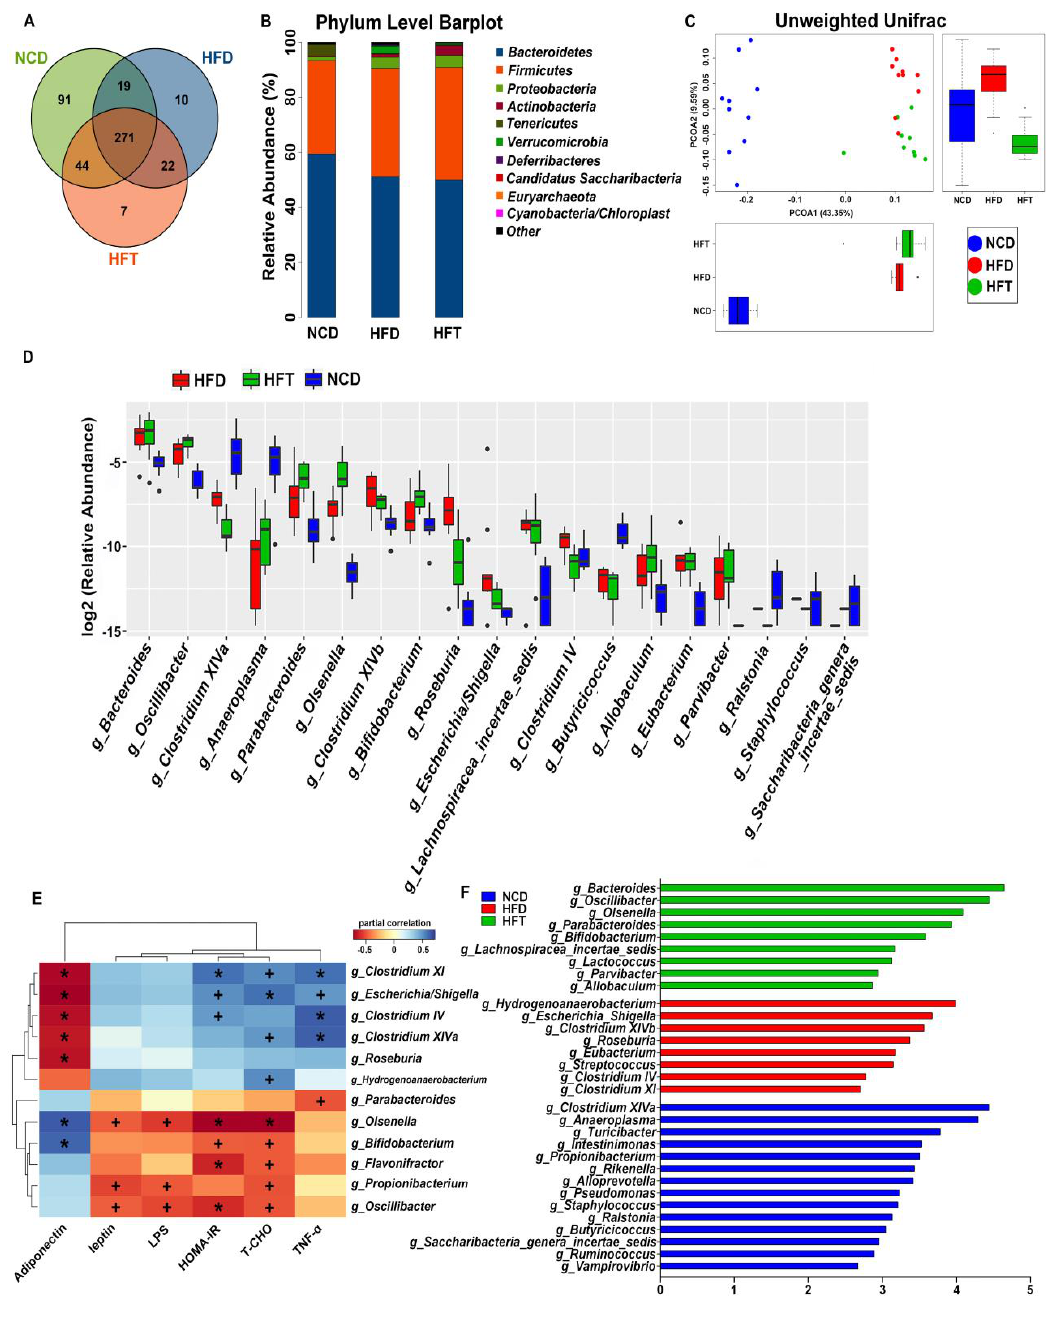
Figure 5. HFD and T17 administration altered the diversity and composition of gut microbiota. ( A ) Venn Diagram of operational taxonomic units (OTUs), ( B ) bar plot of microbial communities at the phylum level, ( C ) PCoA plot based on unweighted UniFrac distances, ( D ) boxplot based on the significantly altered genera, ( E ) spearman’s correlations between key microbes and metabolic parameters, ( F ) the discovered genera (biomarkers) using linear discriminant analysis effect size with 2.5 as the LDA score threshold. (+ p < 0.05, * p < 0.01). Table 3. The α -diversity indices of gut microbiota in C57BL/6 mice.